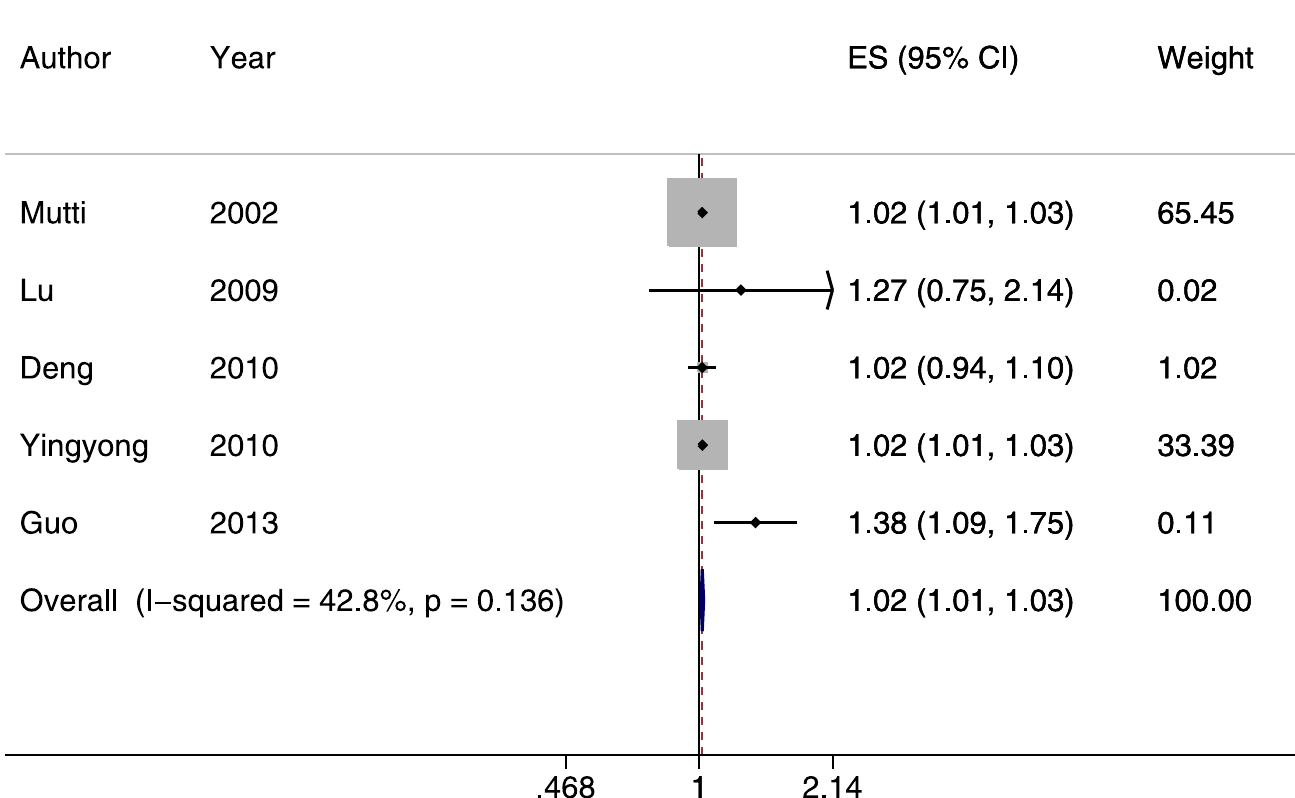
Fig 5. Subgroup of studies reporting an association between near work (per diopter-hour/week) and prevalence of myopia (odds ratio). In children, the odds of myopia increased by 2% (OR:1.02; 95% CI = 1.01 – 1.03; I 2 = 42.8%) for every one diopter-hour more of near work per